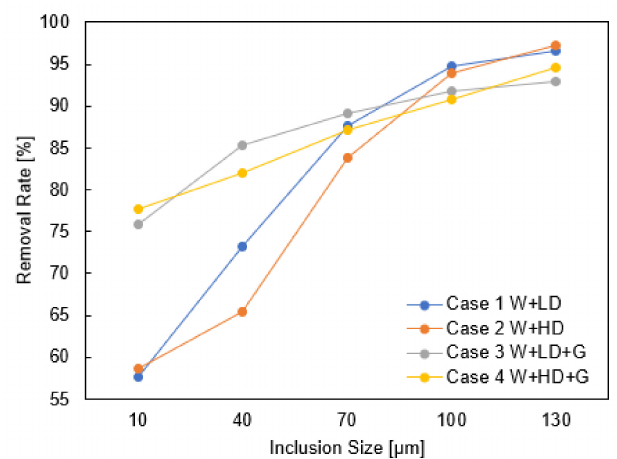
Figure 8. Comparison of the inclusion removal rate with the change of particle size (inclusion density: 3500 kg m − 3 ).